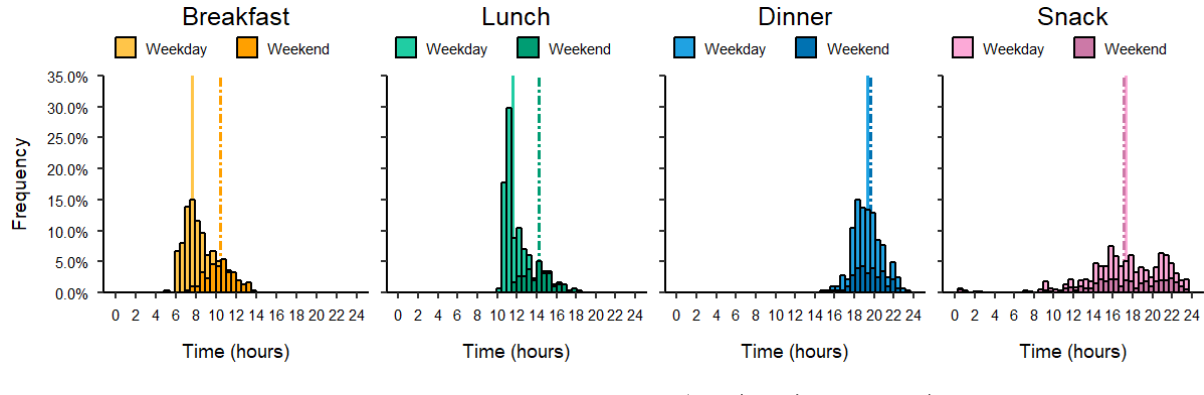
Figure 5. Histogram showing the distribution of all registered meals. Vertical lines in the graphs show the mean values of weekday (solid line) and weekend (dashed line) meal